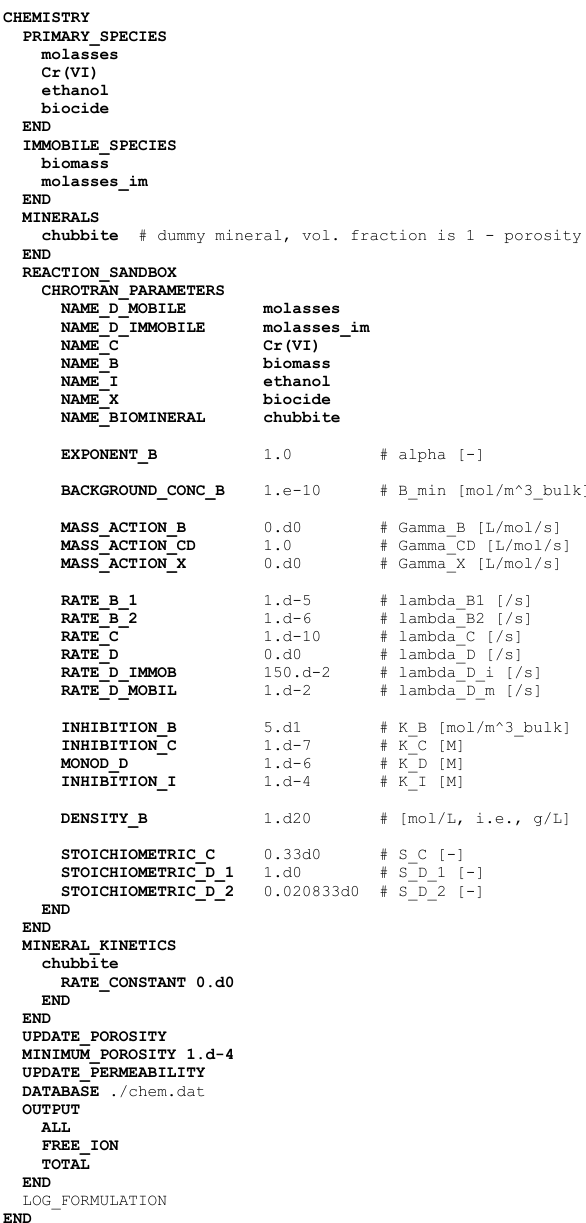
Figure A1. Example CHEMISTRY card for CHROTRAN input file. Bold text should not be altered. However, additional species may be added to the PRIMARY_SPECIES , IMMOBILE_SPECIES , MINERALS , and MINERAL_KINETICS blocks, if desired. Addi- tional sandboxes can also be used in the REACTION_SANDBOX